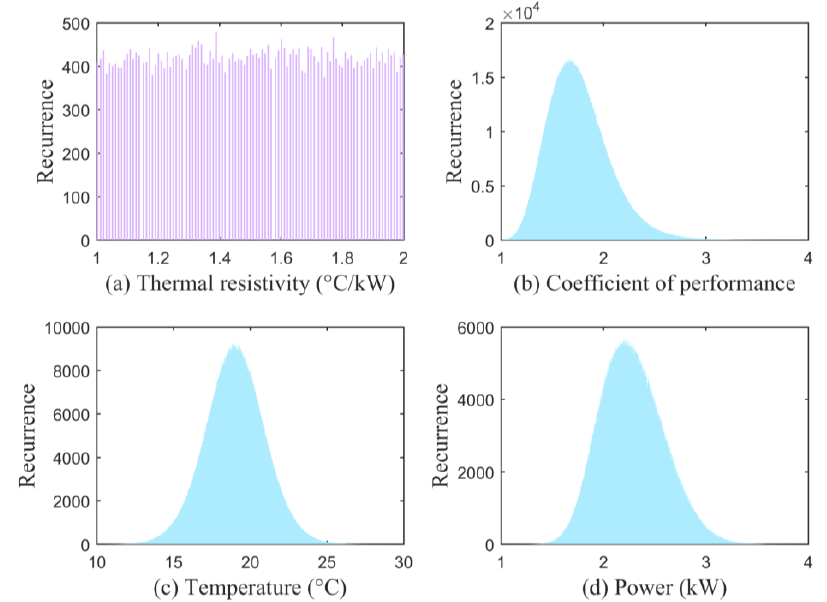
Figure 3. In DNO14, ( a ) the thermal resistivity of modelled buildings using a uniform probabilistic distribution, while considering a normal probabilistic distribution to represent the following characteristics: ( b ) the coefficient of performance of the DHPs, ( c ) the climate-controlled temperatures of the buildings, and ( d ) the electricity loads of the DHPs.